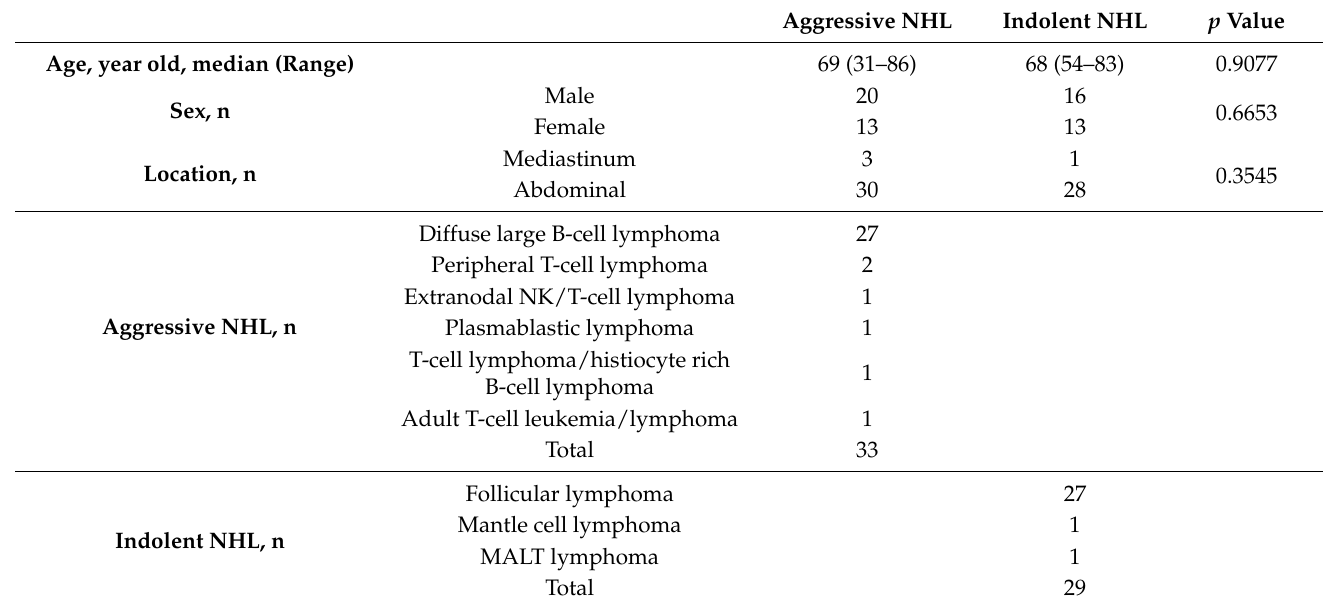
Table 1. Baseline characteristics of the patients.